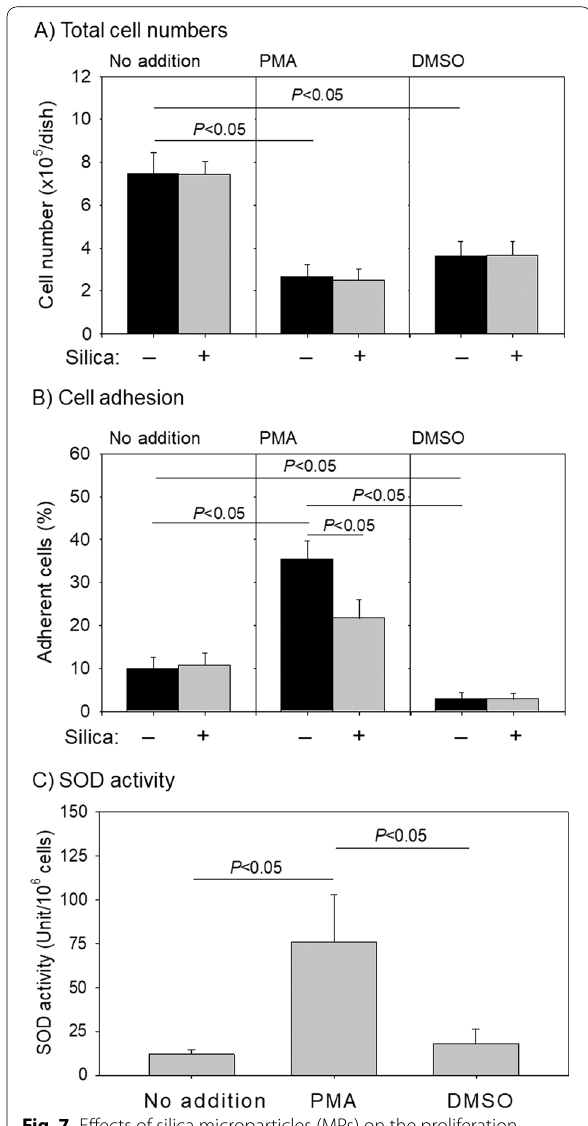
Fig. 7 Effects of silica microparticles (MPs) on the proliferation, adhesion, and superoxide dismutase (SOD) activity of HL60 cells. After 3-day treatments, the suspended HL60 cells were collected and the adherent cells enzymatically detached for cell counting. A Total cell numbers are the sum of suspended and adherent cells n The percentage of the adherent cells was calculated by dividing the adherent cell number by the total cell number n of the control and differentiated HL60 cells